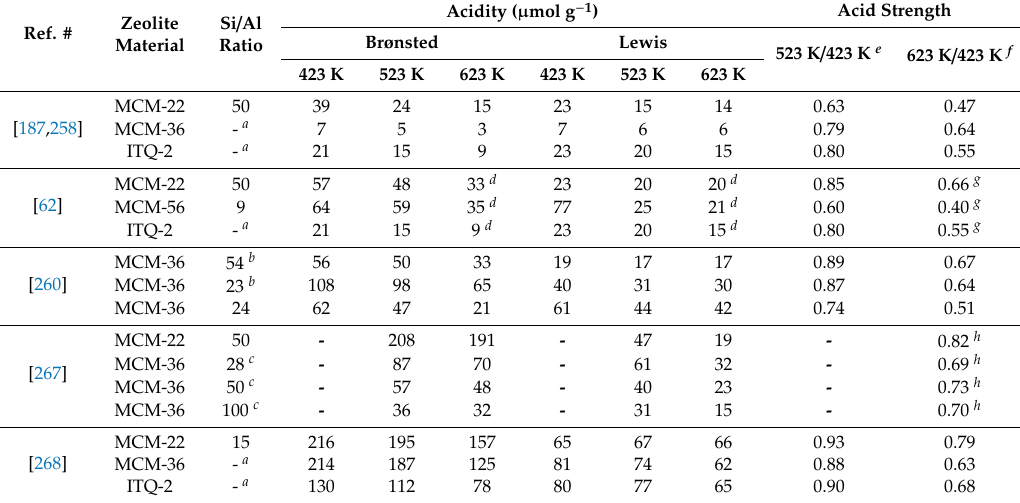
Table 12. Selected literature values of acid site concentration and strength for 2D MWW zeolites evaluated by the FTIR of adsorbed pyridine after desorption at di ff erent temperature conditions. Ref.